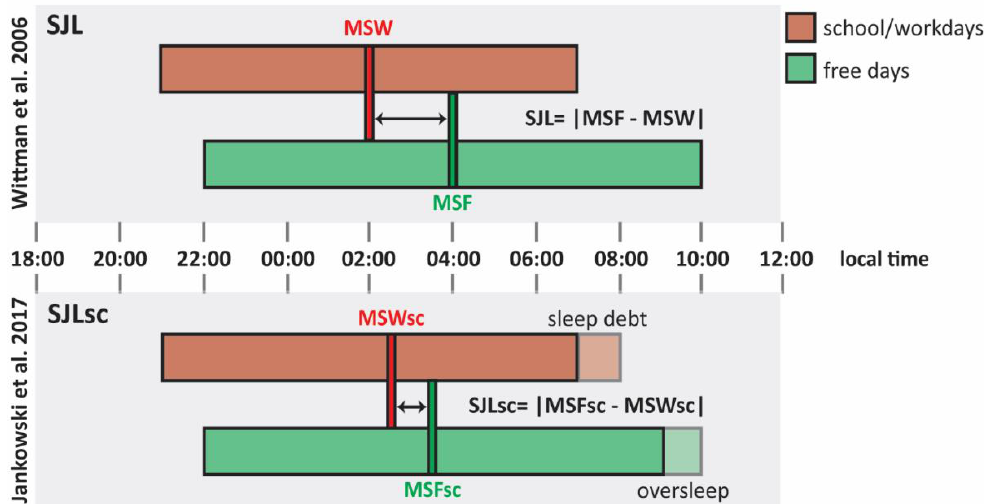
Figure 1. Social jetlag (SJL) and sleep debt-corrected SJL (SJL SC ). Comparison between social jetlag (SJL) calculated as proposed by Wittman et al. [17] and sleep debt-corrected SJL (SJL SC ) as proposed by Jankowski et al. [58]. This schematic representation shows the hypothetical sleep episodes of a late chronotype with an early schedule from Monday to Friday. Bars illustrate sleep episodes, as well as their timing (expressed in local time) and duration, on school/work days (red bars) and free days (green bars). Following the formula proposed by Jankowski et al. [58] (lower part of the illustration), MSW SC results delayed if compared to MSW due to sleep debt school/work days (red dashed block), while MSF SC is anticipated if compared to MSF because of the oversleep of free days (green dashed block). Abbreviations: MSF, midsleep on free days; MSW, midsleep on work days; MSF SC , oversleep-corrected midsleep on free days; MSW SC , sleep debt-corrected midsleep on work days.